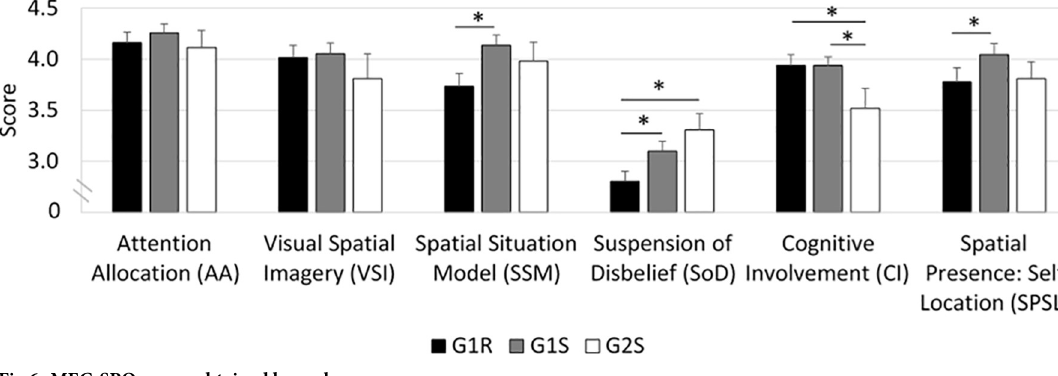
Fig 6. MEC-SPQ scores obtained by each